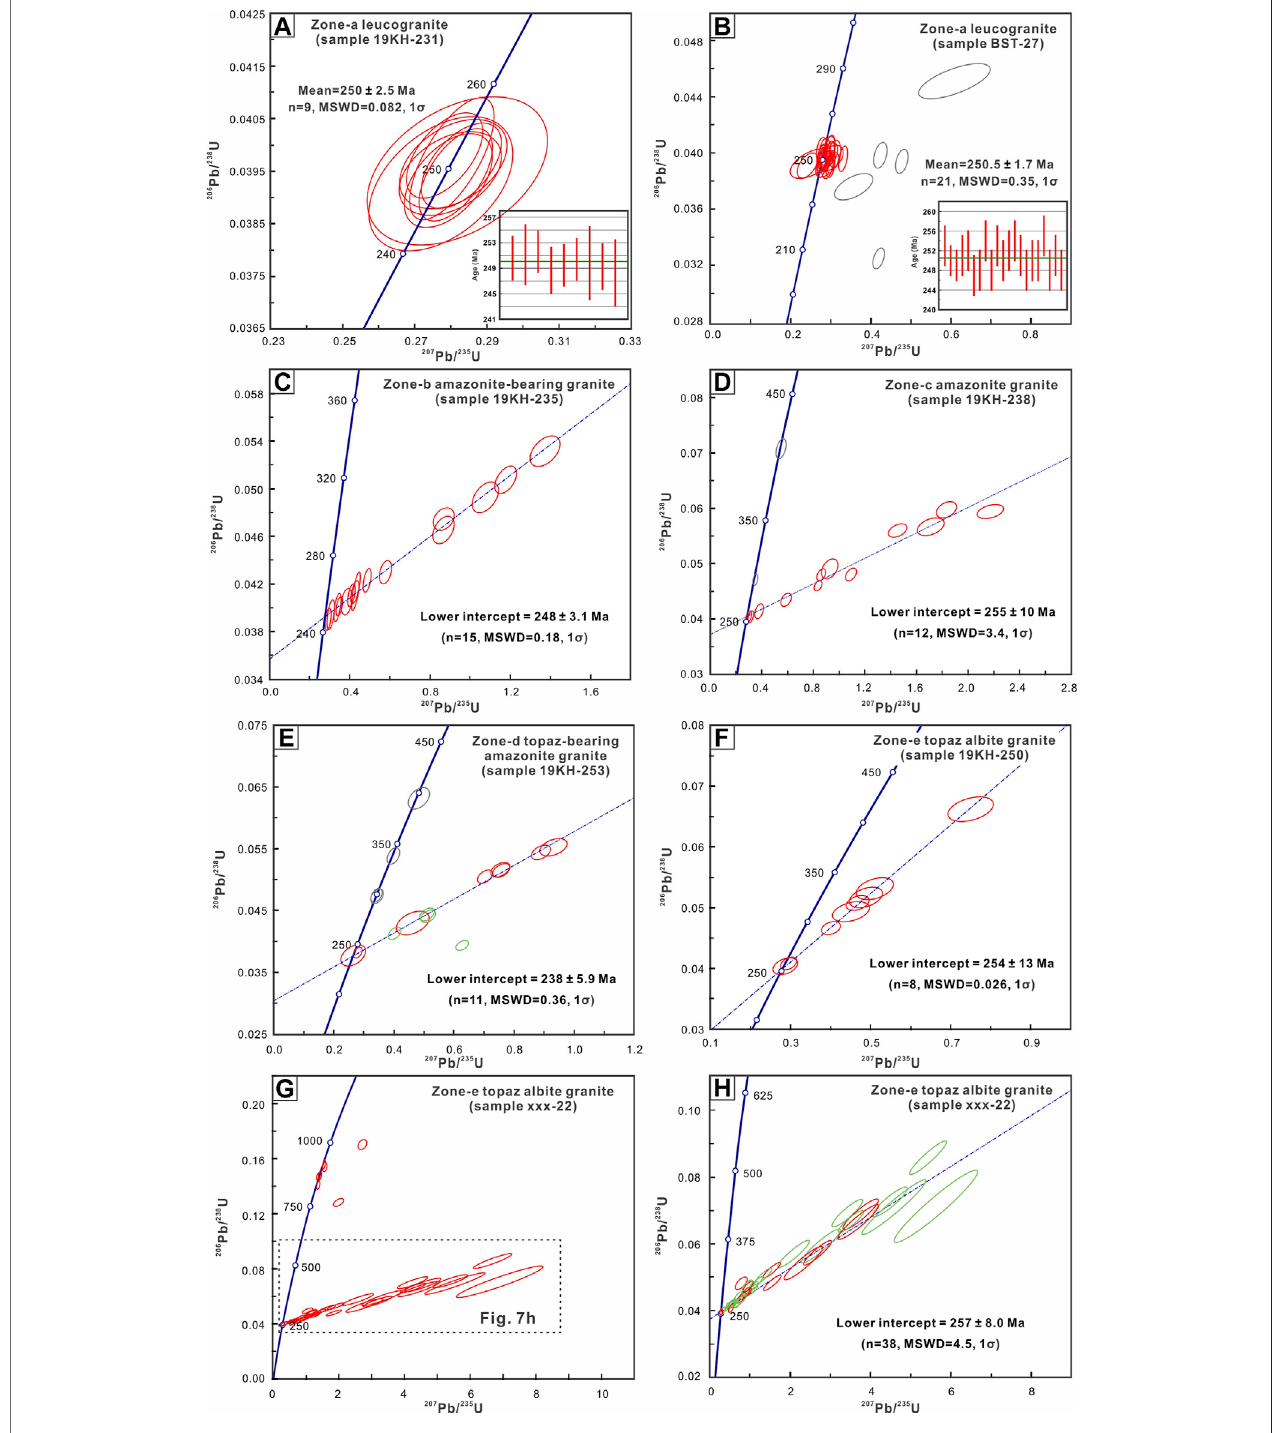
FIGURE 7 | (A,B) U – Pb concordia diagrams and weighted average ages of type – I zircon from zone – a. (C – H) U – Pb concordia diagrams of type – I (red circle) and type – II (green circle) zircons from the upper zones of the BST pluton.